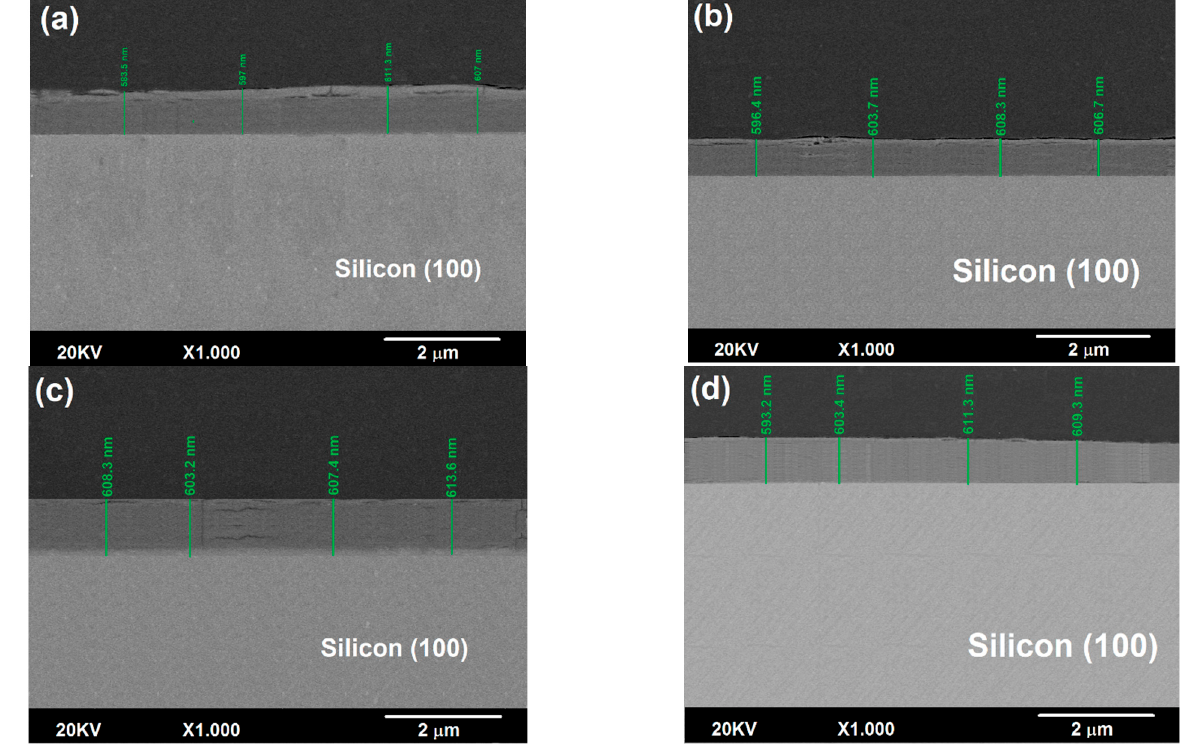
Figure 9. SEM micrograph of the cross-section for ( a ) TaC, ( b ) HfC, ( c ) Ta 70 -Hf 30 -C and ( d ) Ta 30 -Hf 70 -C.